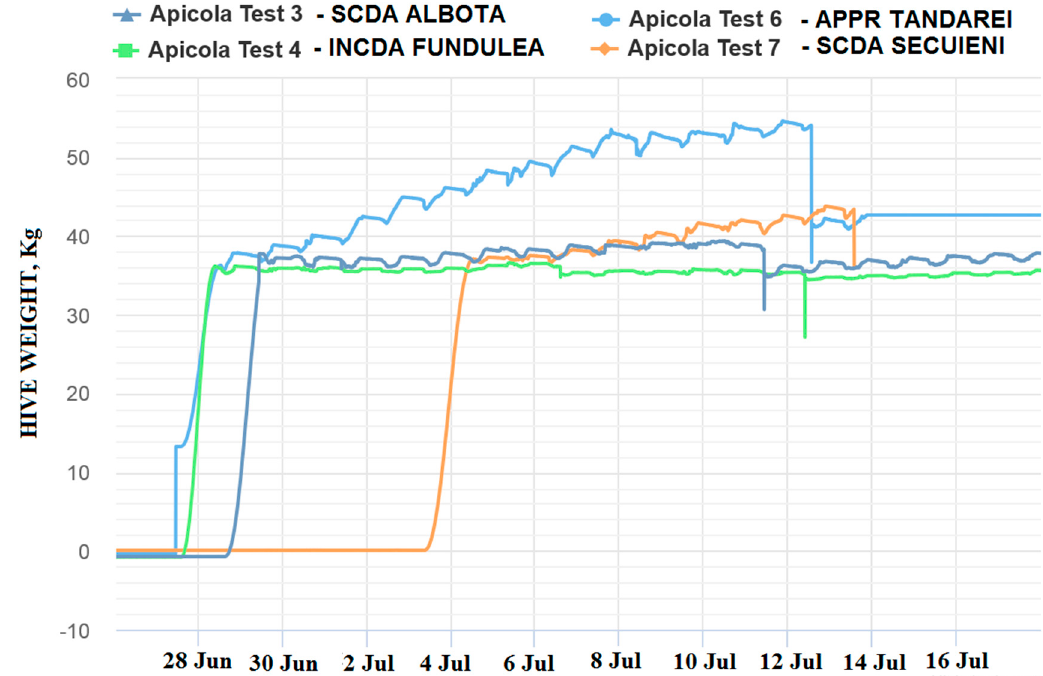
Figure 5. The weight gain (kg) monitored by experimental electronic hives in the sunflower honey flow in four locations from 29 June to 14 July